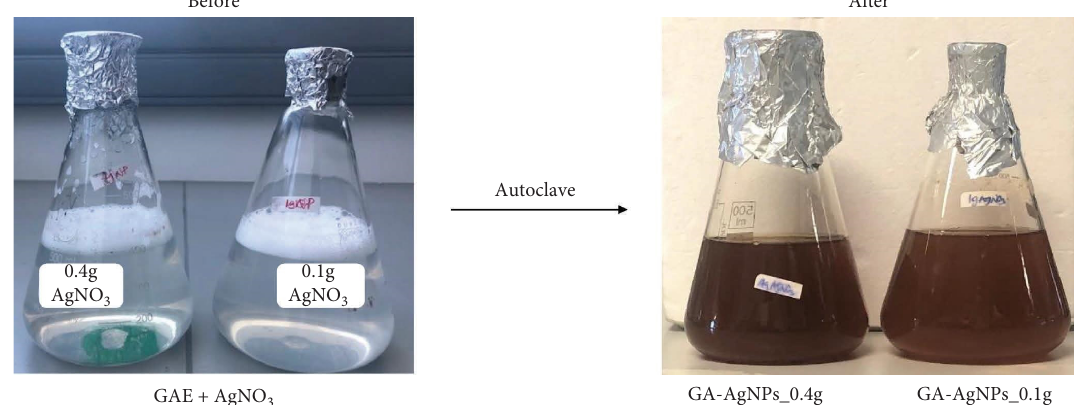
3 and GAE for the synthesis of GA-